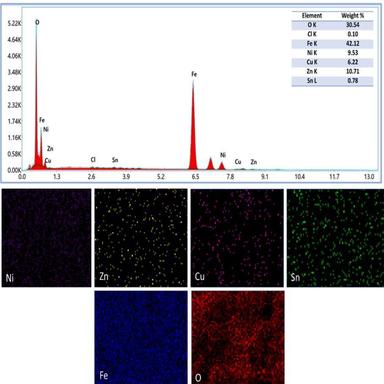
EDX spectrum and Elemental mapping of NCZFe2-4xSn3xO4 (x = 0.02) NSFs.